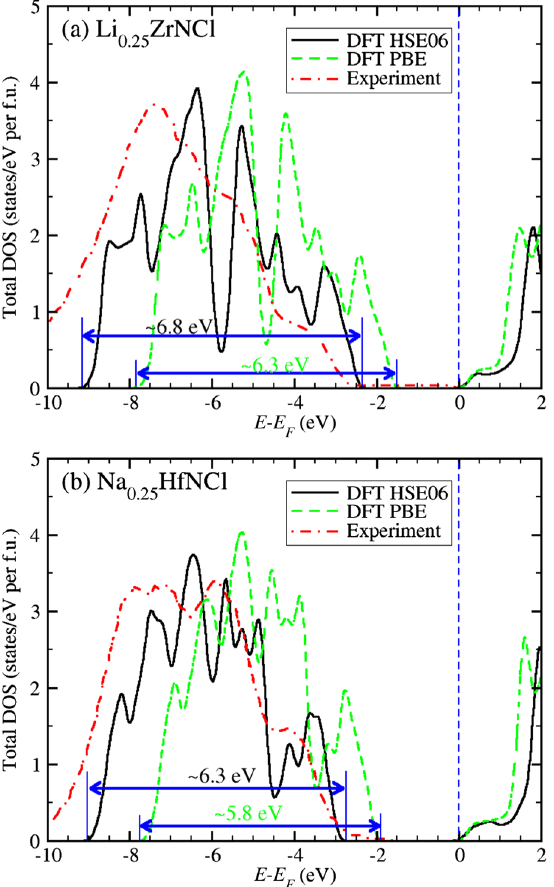
FIG. 8. Band structure and density of states of (cid:1) -HfNCl. The FIG. 7. Density of states of (a) Li ZrNCl and 0 : 25 band structure and density of states of (cid:1) -HfNCl are calculated HfNCl . The theoretical total DOS is calculated using (b) Na 0 : 25 using the PBE functional with the experimental crystal structure both the PBE functional and the HSE06 hybrid functional. [80] and with the experimental crystal structure with the Hf and/ Doping is approximated by placing two Li = Na atoms at (0, 0, or N atoms shifted in the ab plane (top panel) and along the c 0) and (0.5, 0.5, 0) in the 2 (cid:5) 2 (cid:5) 1 supercell. The experimental axis (bottom panel) such that the Hf-N bond is compressed or data are the photoemission spectra taken from Ref. [76] for stretched by 0.09 A˚ . For simplicity, the different layer stacking ZrNCl and from Ref. [77] for Na HfNCl . Na 0 : 42 0 : 22 along the c axis is ignored. Note that the Fermi level is set to the bottom of the conduction band, since we are interested in (cid:2) point in ZrNCl = HfNCl upon 0 : 25 = f : u : electron electron doping. The corresponding numbers are 40% = 19% ( 13% = 17% ) or 10 : 2 = 3 : 5 meV ( 3 : 4 = 3 : 0 meV ) for the E mode involving the in-plane Zr = Hf vibration. g